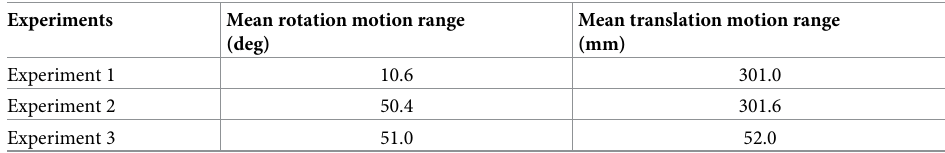
Table 2. Motion range